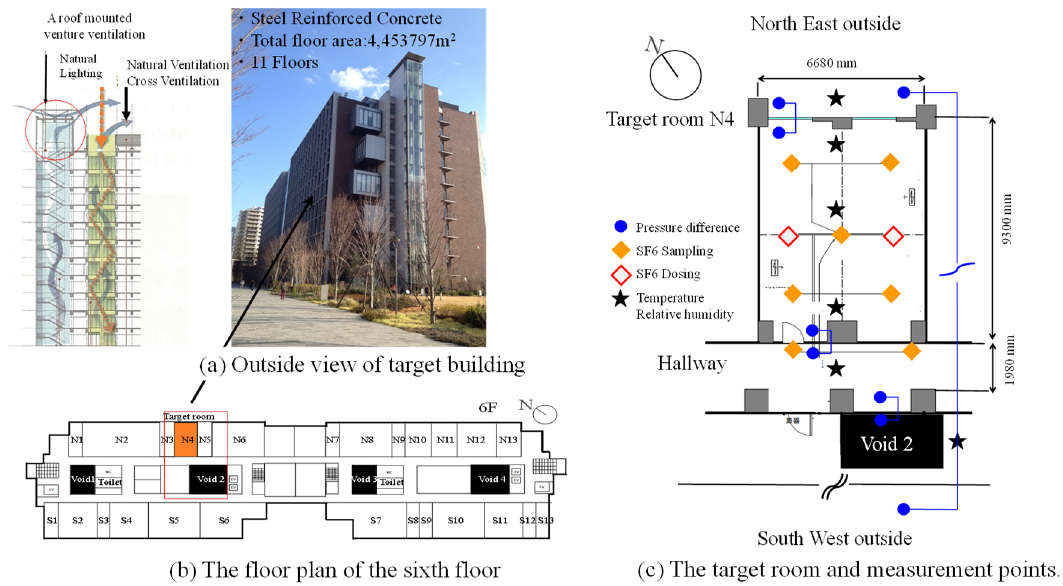
Figure 2. Schematic representation of the target building and measurement points: ( a ) outside view of target building; ( b ) the floor plan of the sixth floor and ( c ) the target room and measurement points.